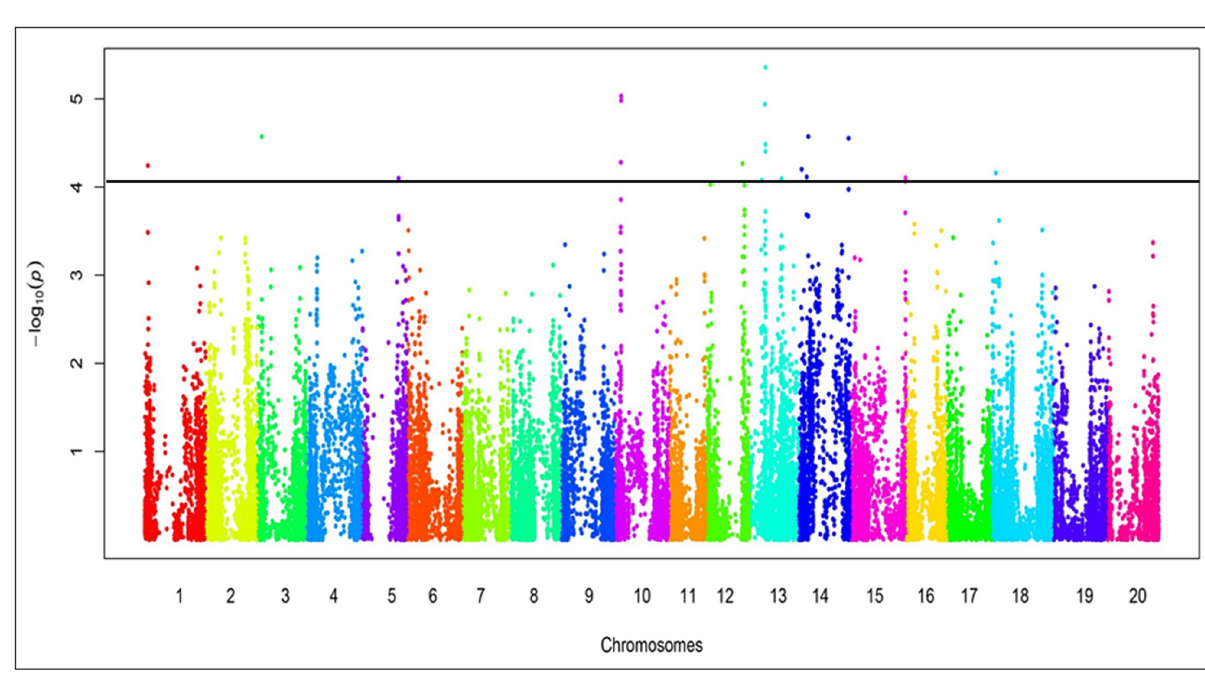
Fig 4. Manhattan plot of the SNPs associated with the foliar SDS scores of the 254 PI lines. The − log10 p -values from a genome-wide scan are plotted against the positions of each of the SNPs on 20 chromosomes. The horizontal blue line indicates the genome-wide significance threshold (FDR < 0.05). SNPs in Manhattan plot were placed in kb